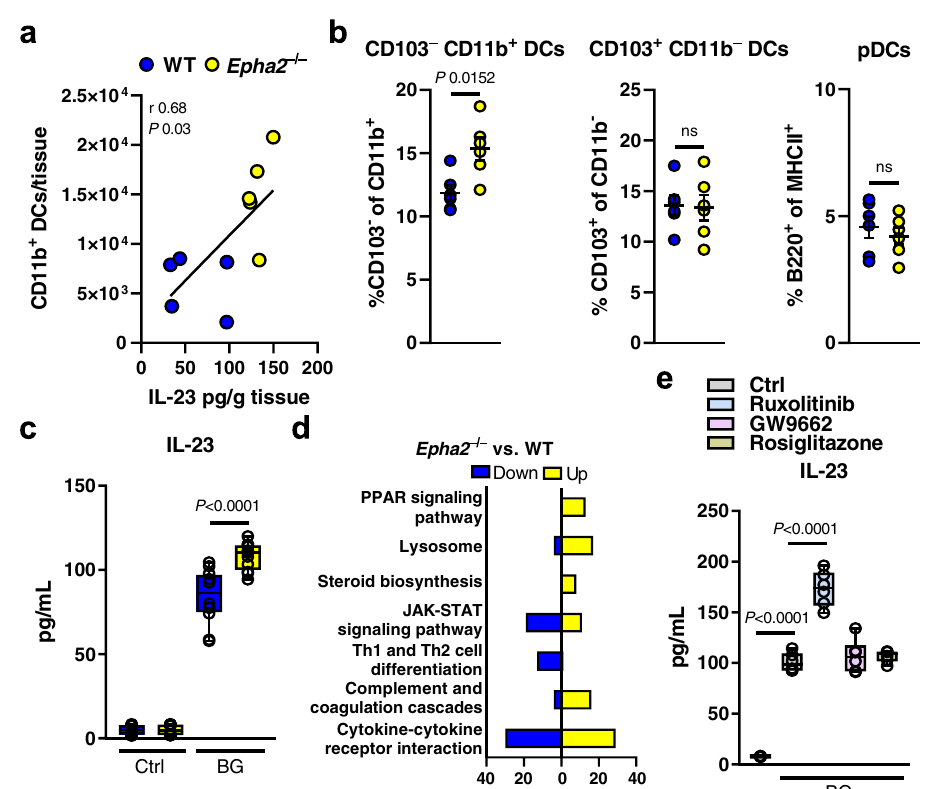
Fig. 5 | EphA2 signaling impairs IL-23 secretionin BMDCs.a Correlation of IL-23 kidneylevelsandcDCin fi ltrationduringcandidiasisinWTand Epha2 – / – mice. N =5; combined data of two independent experiments. Pearson correlation coef fi